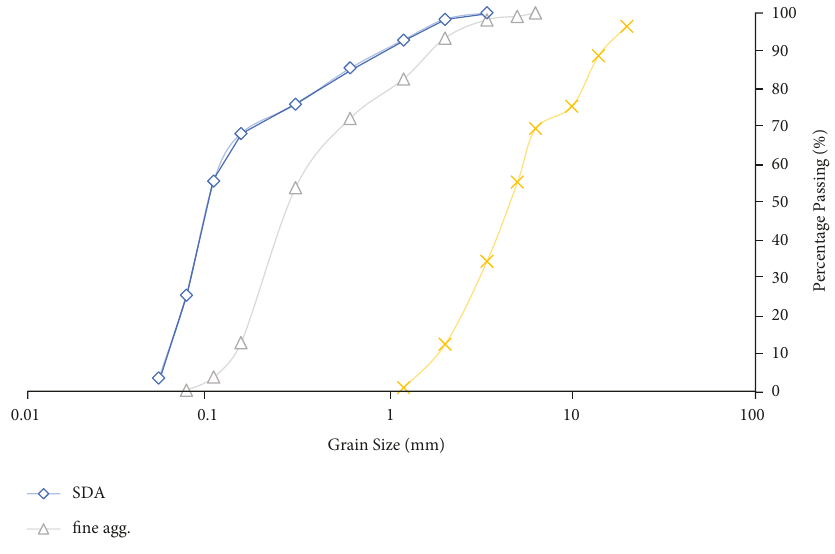
Figure 6: Sieve analysis graph.